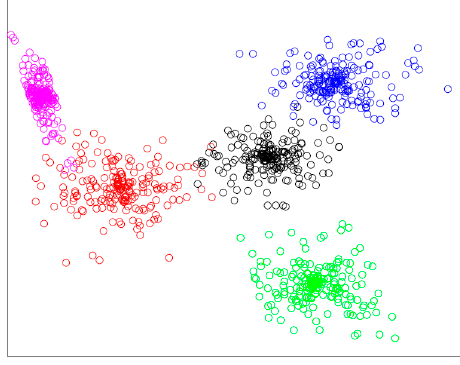
Figure 7. The result of clustering.